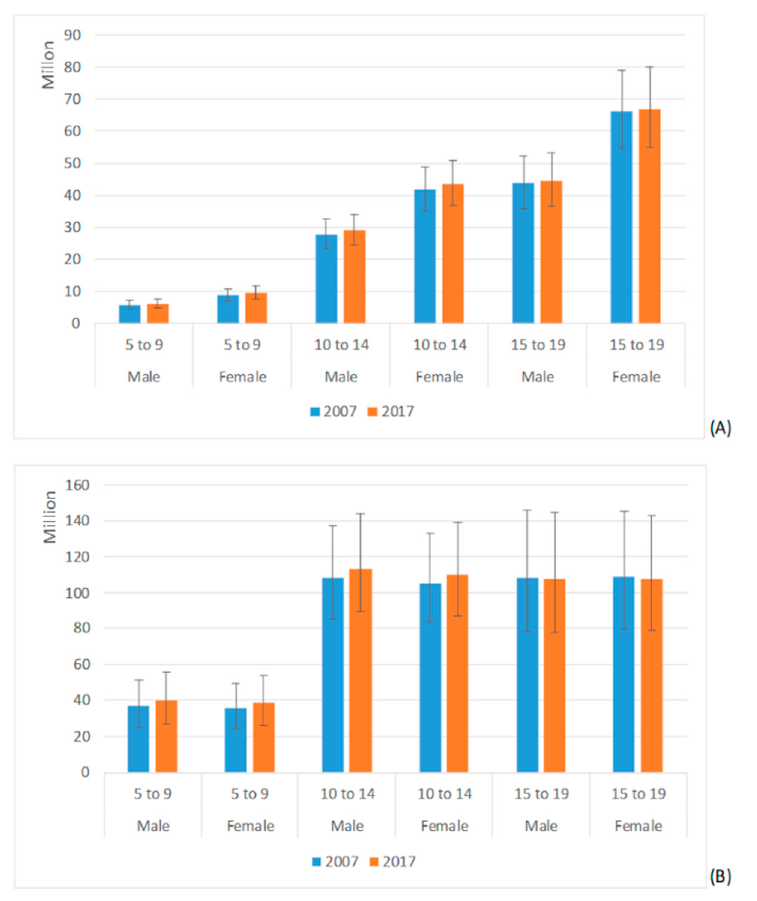
Figure 1. Global prevalence of migraine, and ( A ) TTH ( B ) by gender and age group. Estimates are reported in millions, with mean and 95% UI.